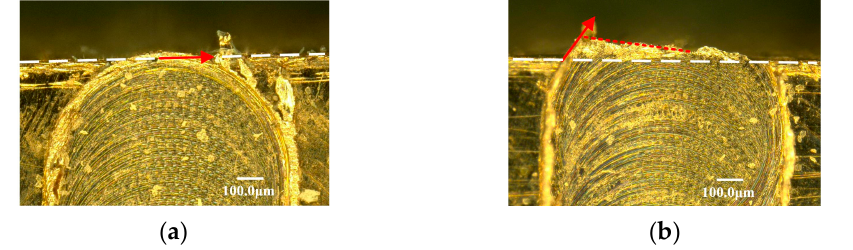
Figure 9. Exit burr formation process in micro milling. ( a ) Cut out at the middle point. ( b ) Cut out point move to side point.